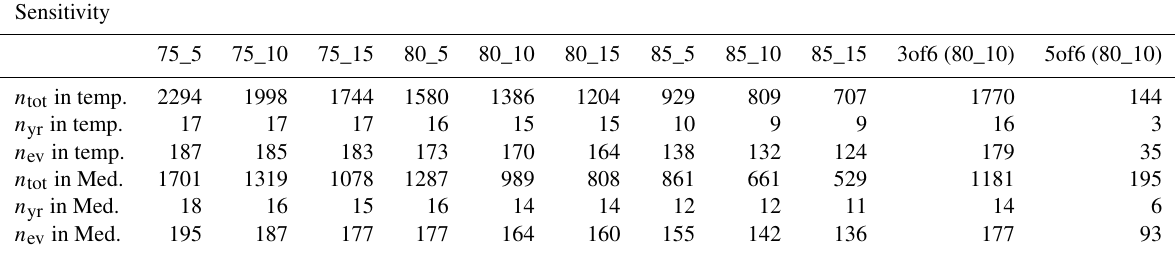
Table A1. Number of events ( n tot ), number of years with at least 10 low-NDVI grid cells ( n yr ), and number of events per sub-sample ( n ev ) in the temperate and Mediterranean biome for different combinations of threshold parameters. The column title indicates the setup with c min ev = 4 and different AR min and FA min combinations separated by an underscore – except for the last two columns. These denote tuning the threshold parameter c min ev to 3 and 5, while AR min = 80% and FA min = 10%. Sensitivity